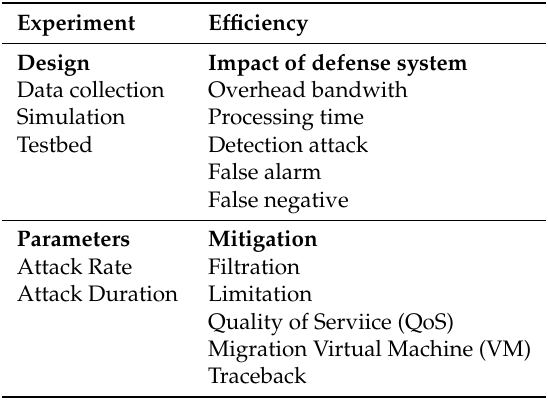
Table 2. Summary of Evaluation Defense System in DDoS